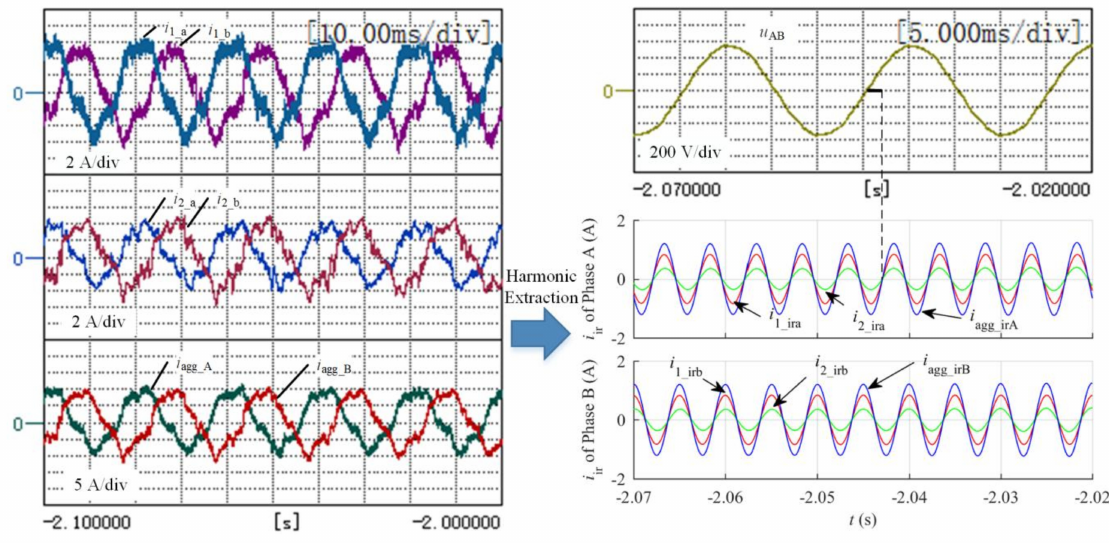
Figure 15. Actual positive sequence 200 Hz current.